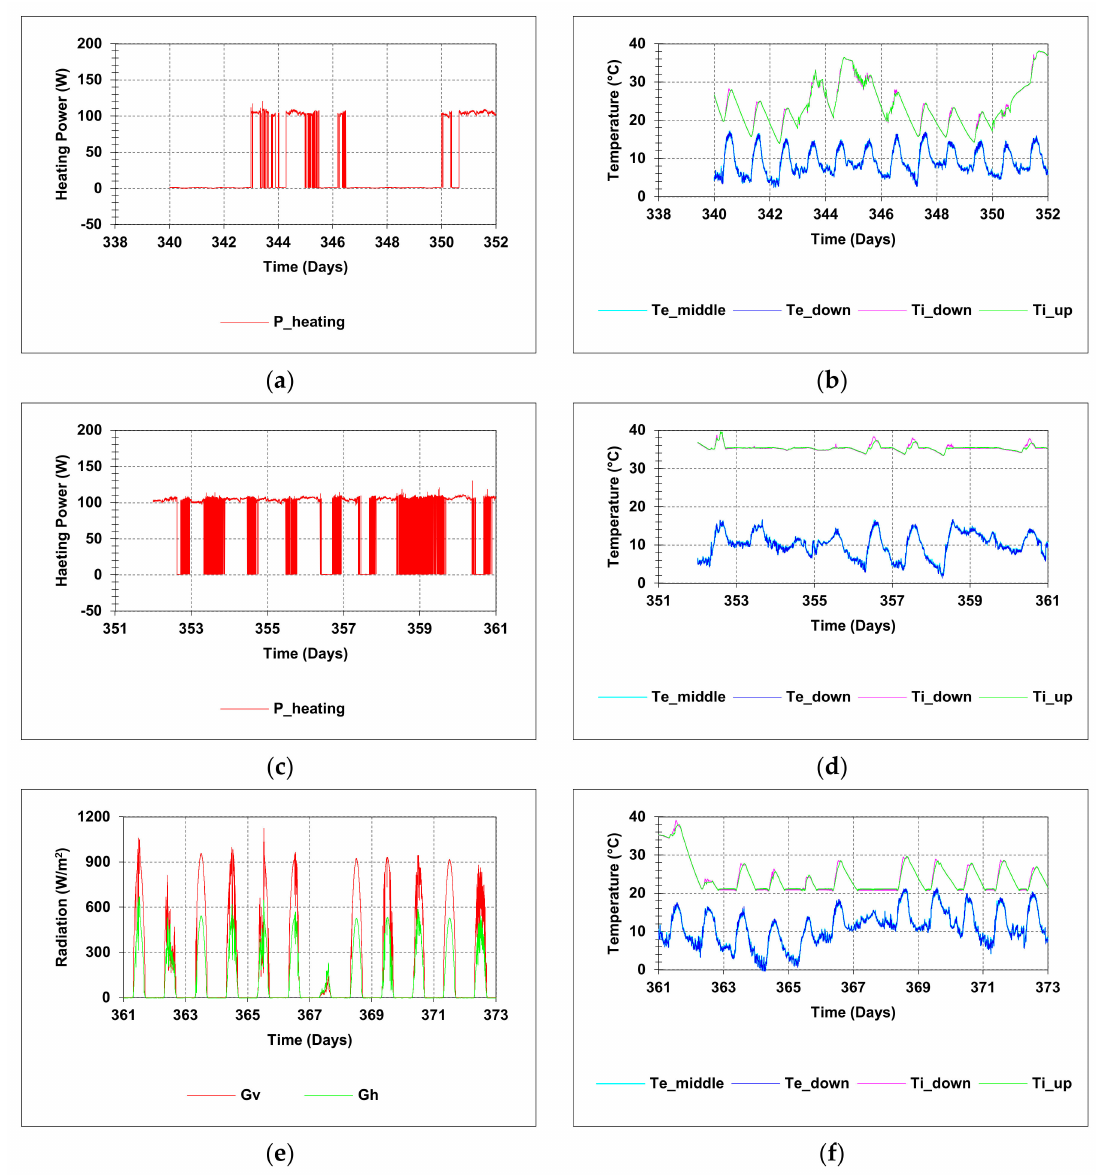
Figure 2. Data overview where P heating is the heating Power; G v and G h are the vertical and the horizontal global solar radiation, T i _down and T i _up are the two measurements of the indoor air temperature, T e _middle and T e_ down are the two measurements of the outdoor air temperatures. ( a ) Heating power. Series 16, ( b ) indoor and outdoor air temperatures. Series 16, ( c ) heating power. Series 17, ( d ) indoor and outdoor air temperatures. Series 17, ( e ) vertical and horizontal global solar radiation. Series 18, ( f ) indoor and outdoor air temperatures. Series